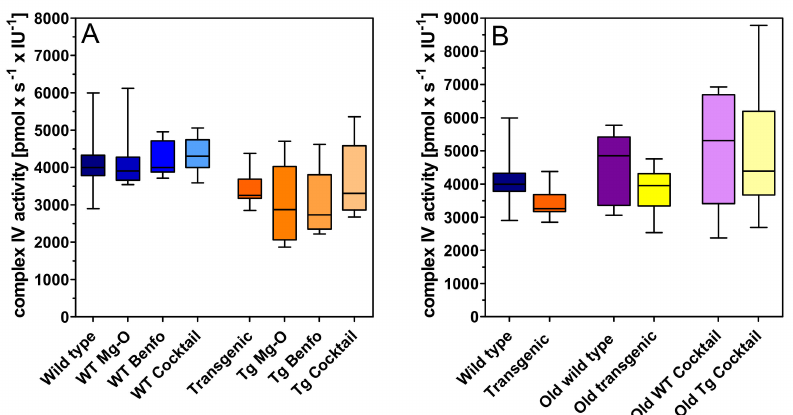
Figure 5. Oxygen flux of complex IV in ( A ) young wild-type and transgenic rats and ( B ) young and old rats treated with cocktail. Substrates, uncoupler and inhibitors were used to measure oxidative phosphorylation related oxygen consumption as described in methods. Raw data were normalised to mitochondrial citrate synthase activity. A: (left) Treatment in wild type (WT), (right) treatment in transgenic (Tg) animals. Statistical analysis: Data are box plots (lower and upper quartile) with whiskers ( n = 8–10) and were analysed by one-way ANOVA followed by Bonferroni’s multiple comparison test: (a) F3,37 = 0.19, p = 0.90; (b) F3,34 = 1.05, p = 0.38. B: Genotype, treatment and age related effects. Statistical analysis: Data are box plots (lower and upper quartile) with whiskers ( n = 8–10) and were analysed by unpaired t -test.